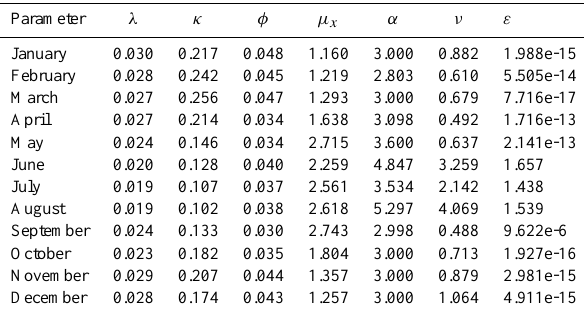
Table A4. Parameter set used for the TBL model.